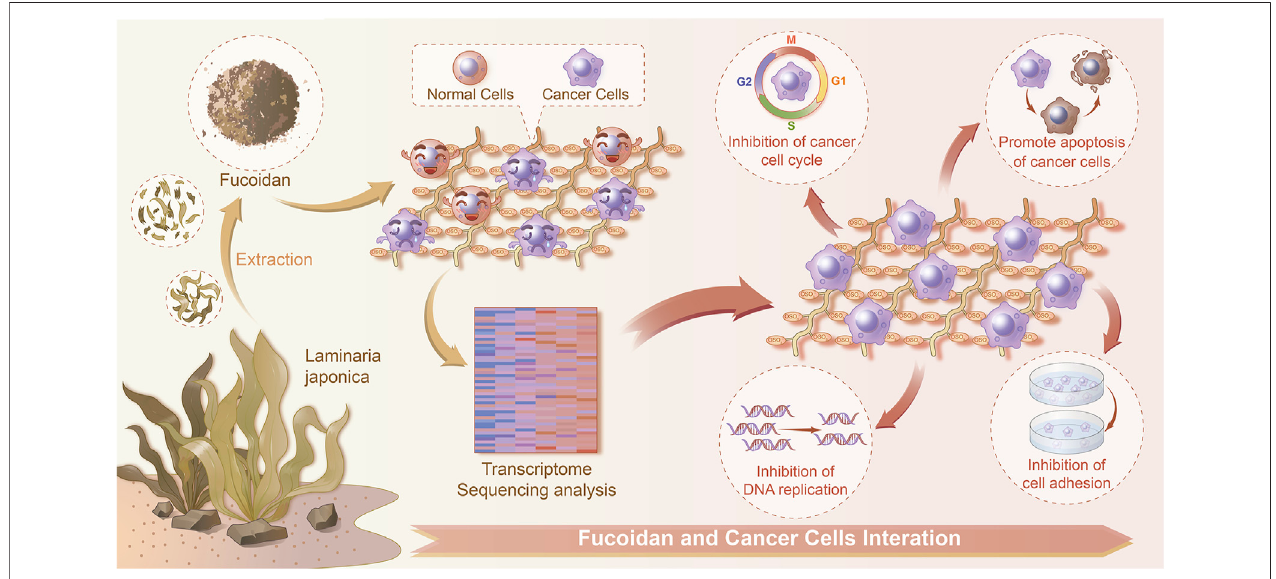
FIGURE 6 | Schematic diagram of the interactions between normal/cancer cell and fucoidan detected by a transcriptome sequencing study.